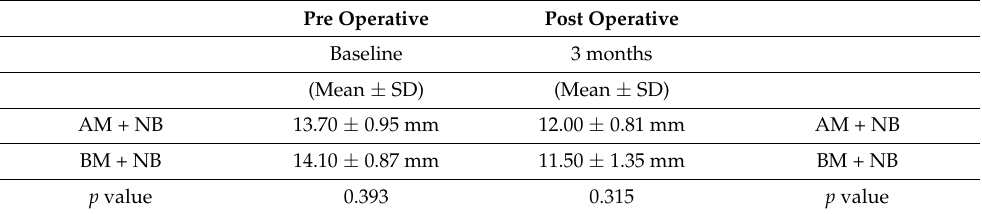
Table 2. Relative Attachment level (Mean [mm] ± SD) at baseline, 3 months and 6 months ( n = 10 pa- tients in each group).